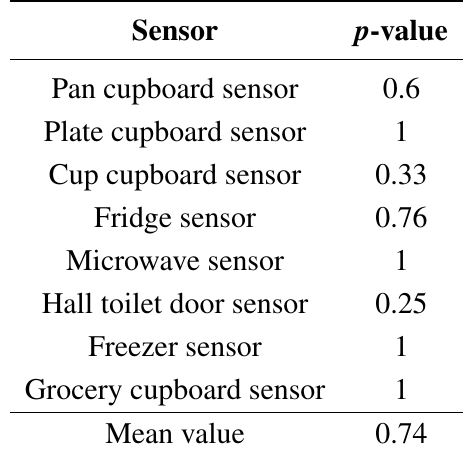
Table 2. The p -values calculated from the Fisher test for each sensor in both datasets and the